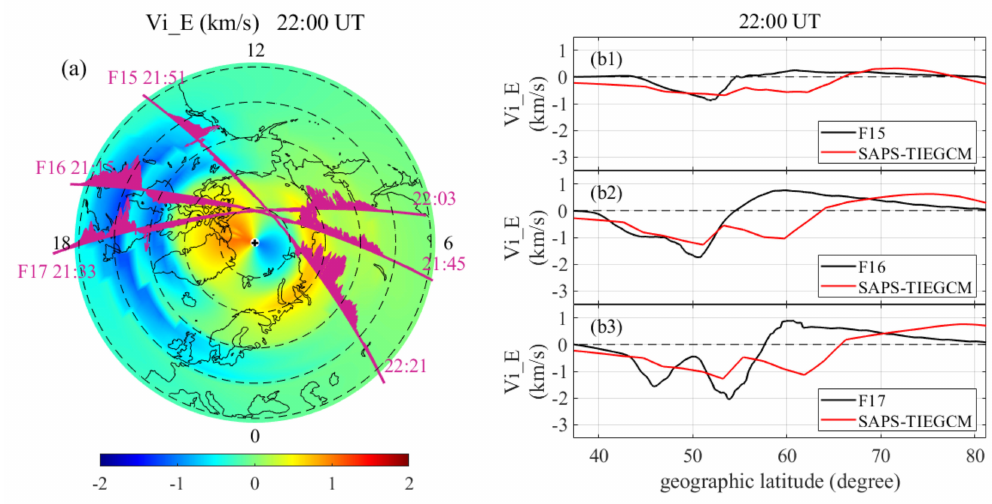
Figure 2. ( a ) Simulated eastward ion velocities V i_E and the projection of DMSP F15/F16/F17 cross- track velocities in the eastward direction at 2200 UT on 17 Mar 2015; ( b1 – b3 ) simulated and observed V i_E on different DMSP tracks.